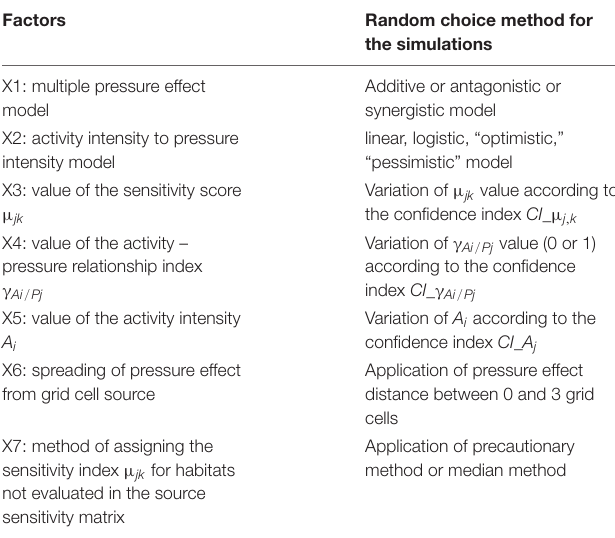
TABLE 3 | Description of factors used in the Monte-Carlo